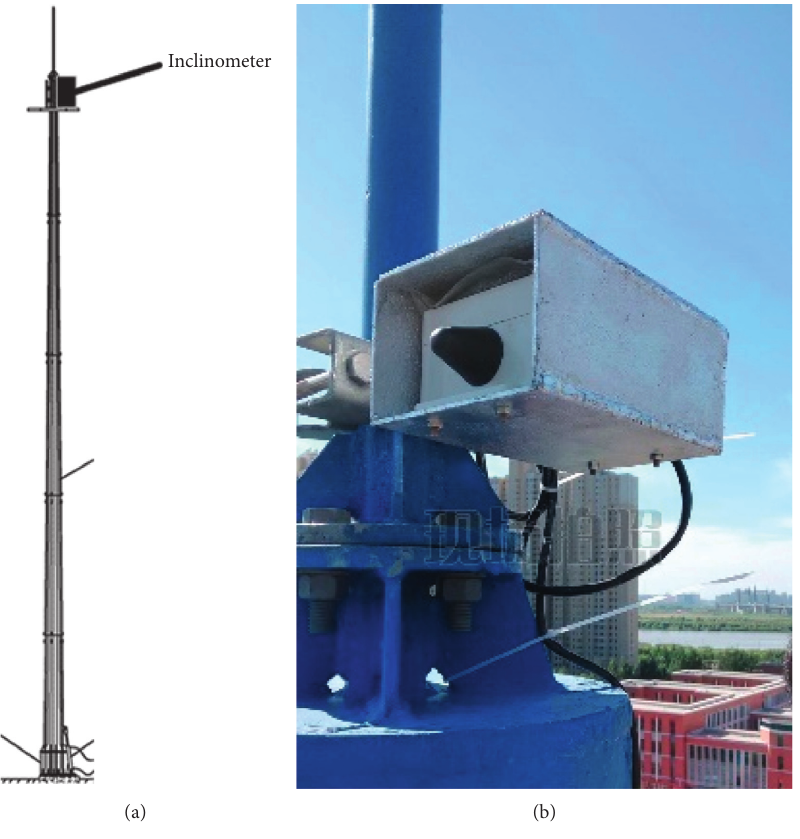
Figure 4: The installation of the SHM system.